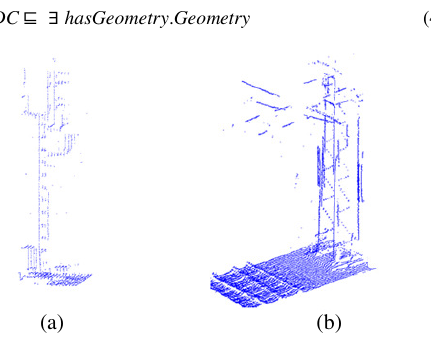
Figure 9. Point cloud sets (a) Signal (b) Mast